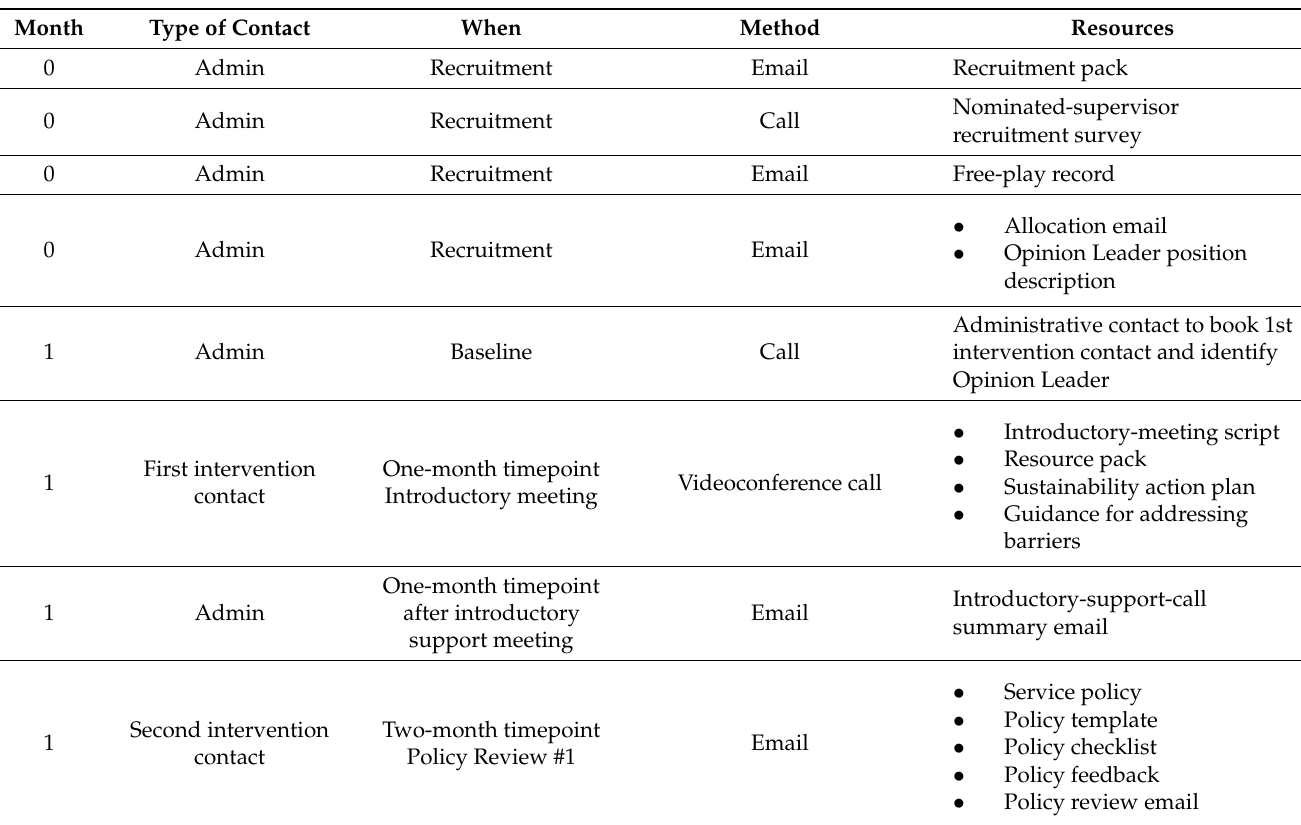
Table 2. Intervention